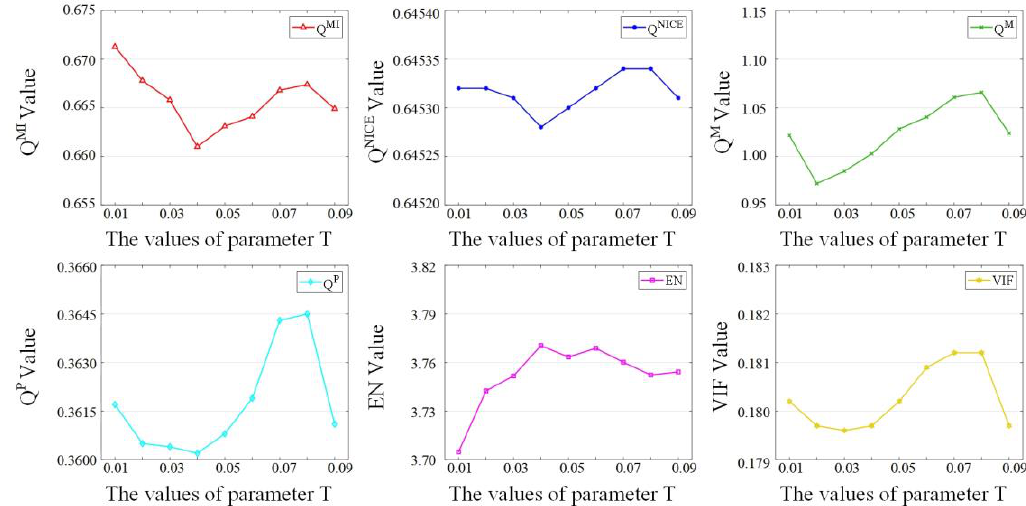
Figure 4. Fusion performance under different values of parameter T .